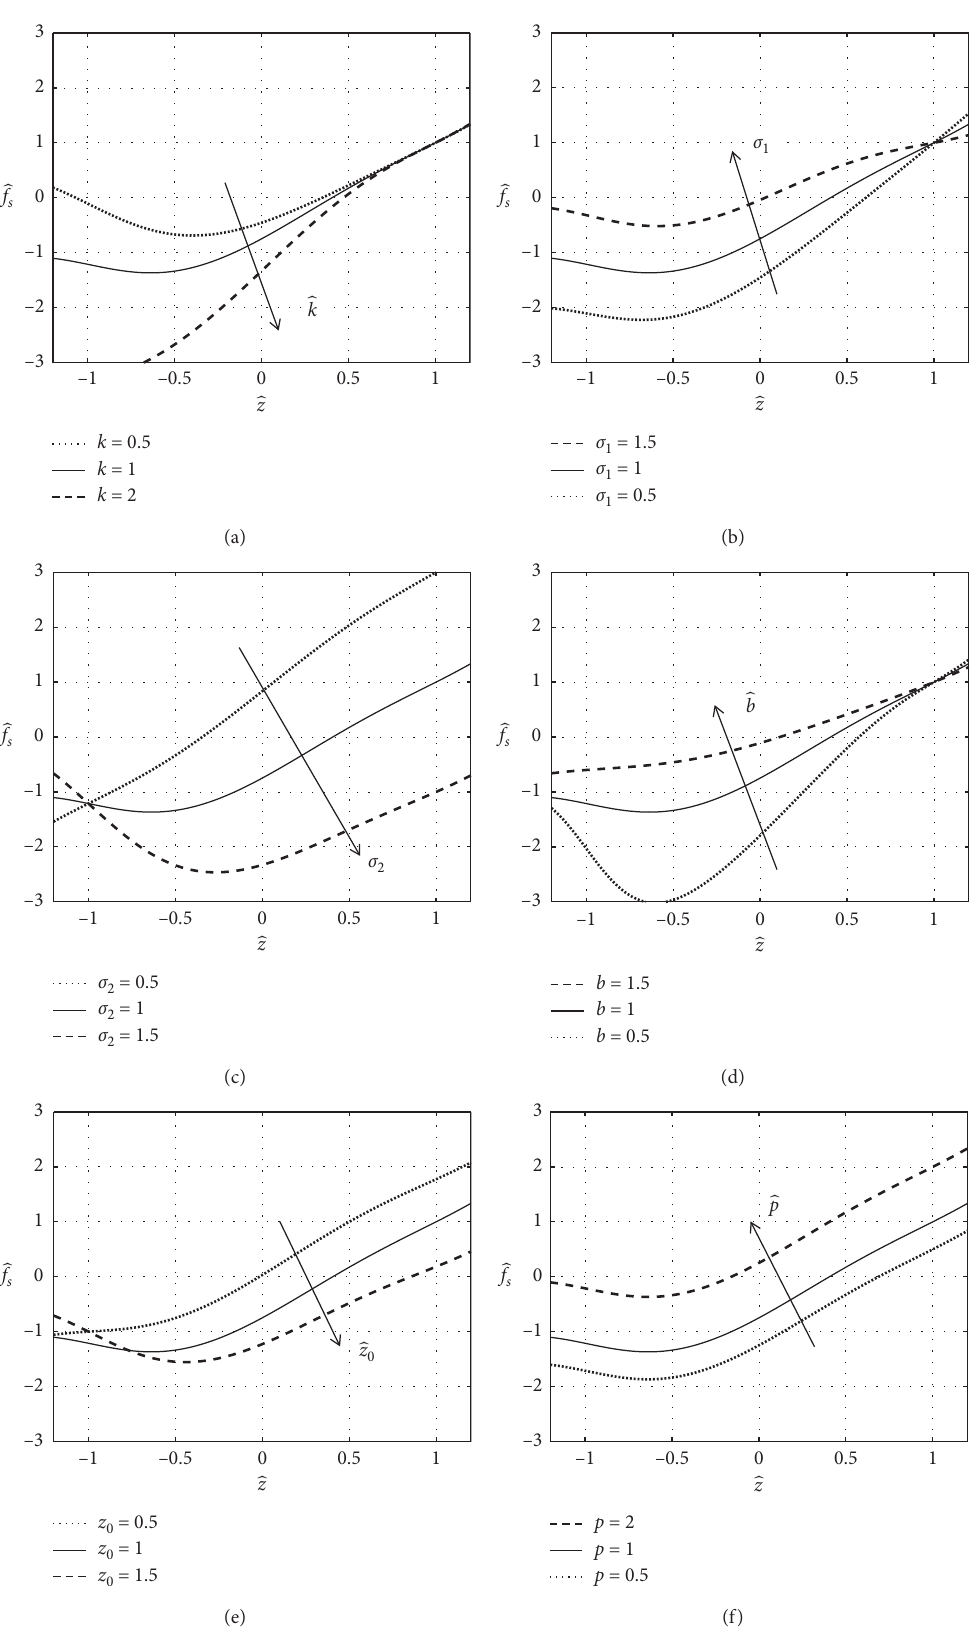
Figure 2: Nondimensional spring restoring force as a function of the nondimensional displacement for different values of the system parameters (a–f), as indicated in the figure legends. The solid line is a common reference to all subfigures and corresponds to the case where 􏽢 k � σ � σ � 􏽢 b � 􏽢 z � 􏽢 p � 1 2 0